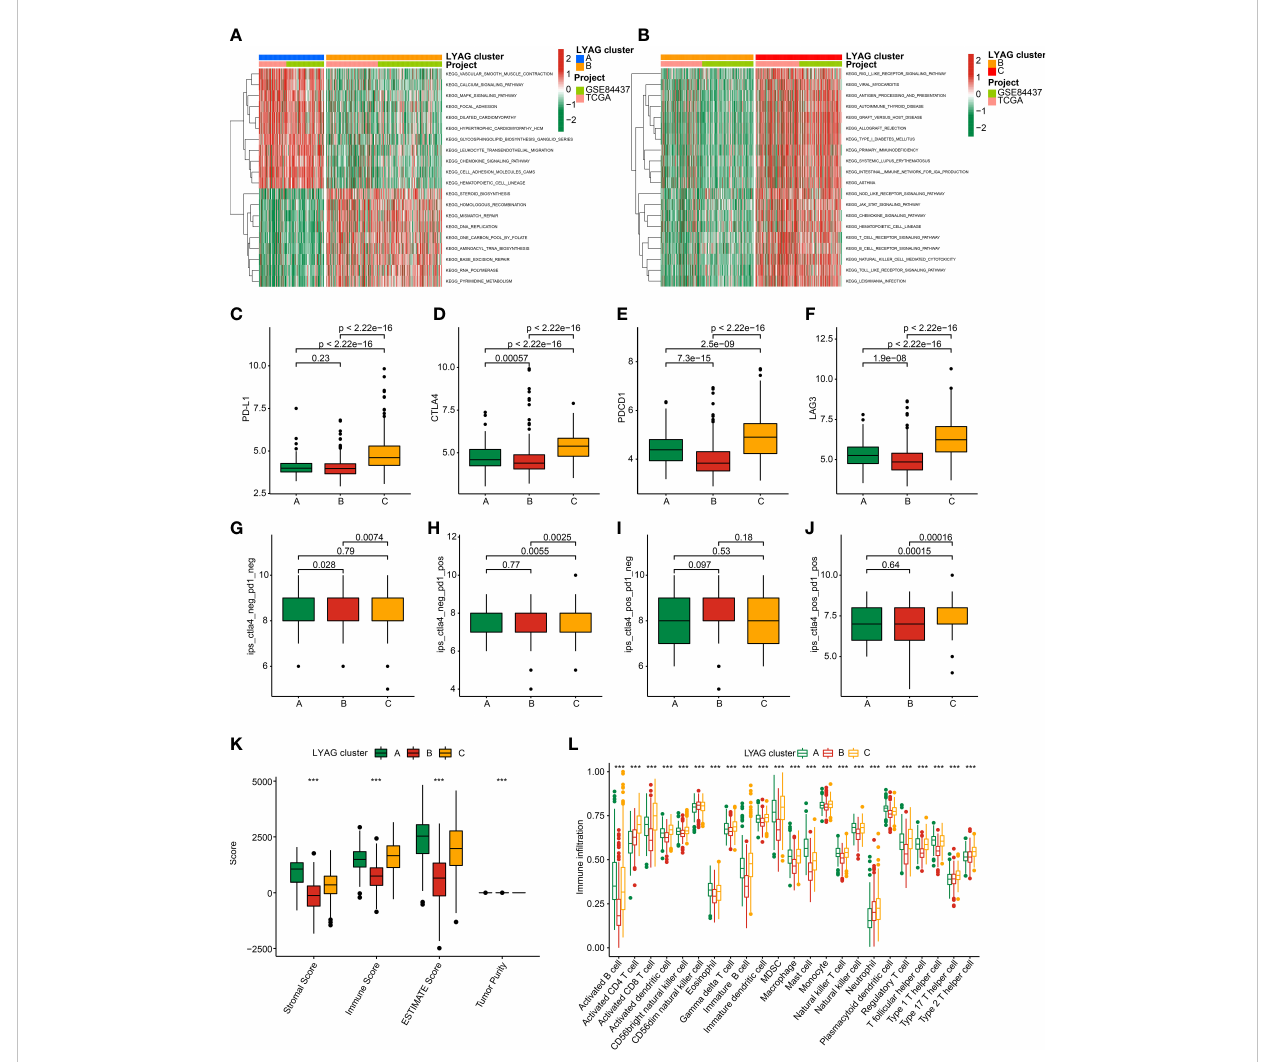
FIGURE 4 TME landscape and immunotherapy response of GC in LYAG subtypes. (A, B) GSVA of KEGG signaling pathways between LYAG subtypes. (C – F) Expression pro fi le of PD-L1, CTLA4, LAG3, and PDCD1in LYAG subtypes. (G – J) IPS evaluation shows the response to PD-1 and CTLA-4 of GC in LYAG subtypes. (K) ESTIMATE assessment. (L) Immune in fi ltration of 23 type immune cells in LYAG cluster A, B and C. ***p <